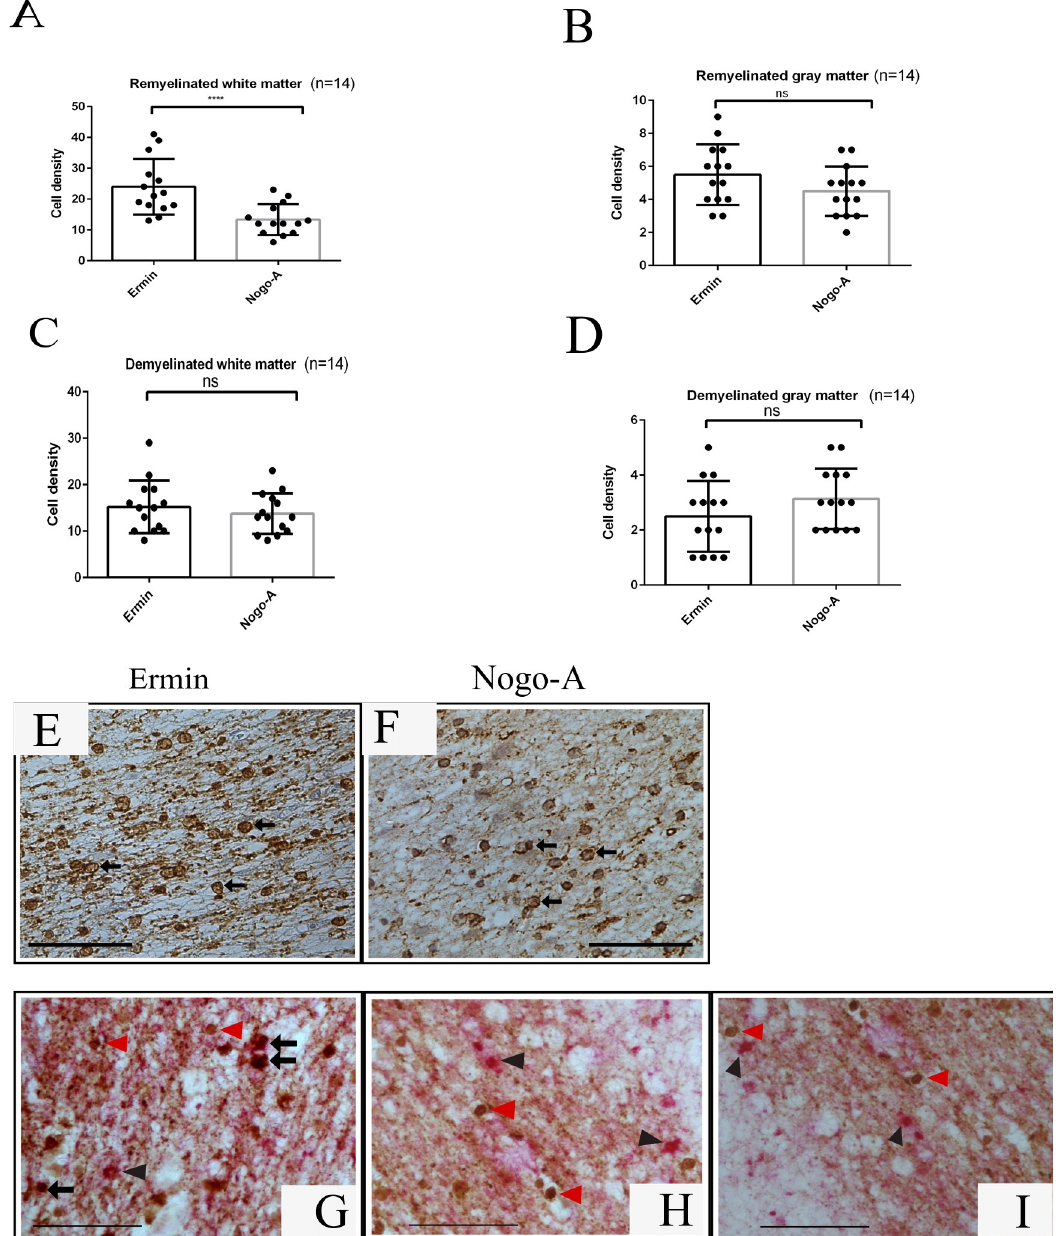
Fig 5. Comparison of ermin and Nogo-A expression in de- and remyelinated MS lesion areas. Density of ermin+ and Nogo-A + cells in remyelinated white matter (A) and gray matter (B) MS lesion areas, and demyelinated white matter (C) and gray matter (D) MS lesion areas. A remyelinated white matter MS lesion area single-label immunostained for ermin (E) and Nogo-A (F). White matter remyelinated MS lesion areas double-label immunostained for ermin (DAB, brown) (G-I) and Nogo-A (AP, red-pink) (G), O1 (AP, red-pink) (H), and O4 (AP, red-pink) (I). Arrows: Double-immunopositive cells. Red arrowhead: Cells immunopositve for ermin, Black arrowhead: Nogo-A (A); O1 (H) and O4 (I). A small proportion of oligodendrocytes were double immunopositive for ermin and Nogo-A (G, arrows). Ermin+ cells were not immunopositve for O1 or O4. Scale bar = 50 μ m, ���� : p < 0.00001, ns: Nonsignificant (p > 0.05).